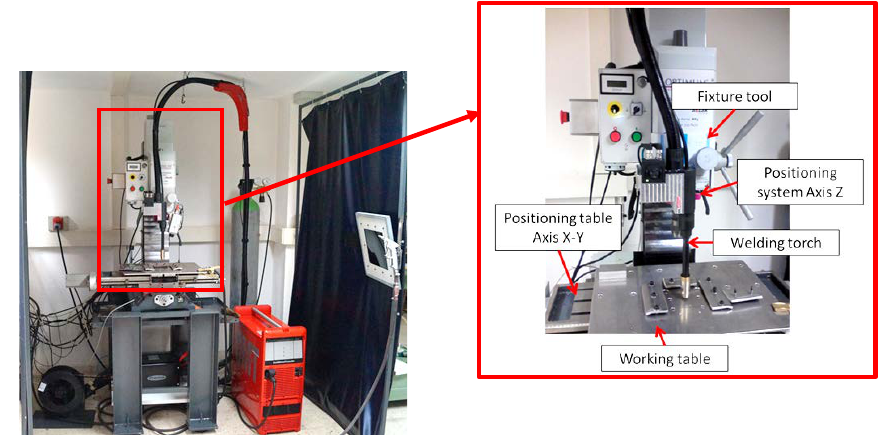
Figure 1. Setup of the integrated WAAM system in the positioning table.